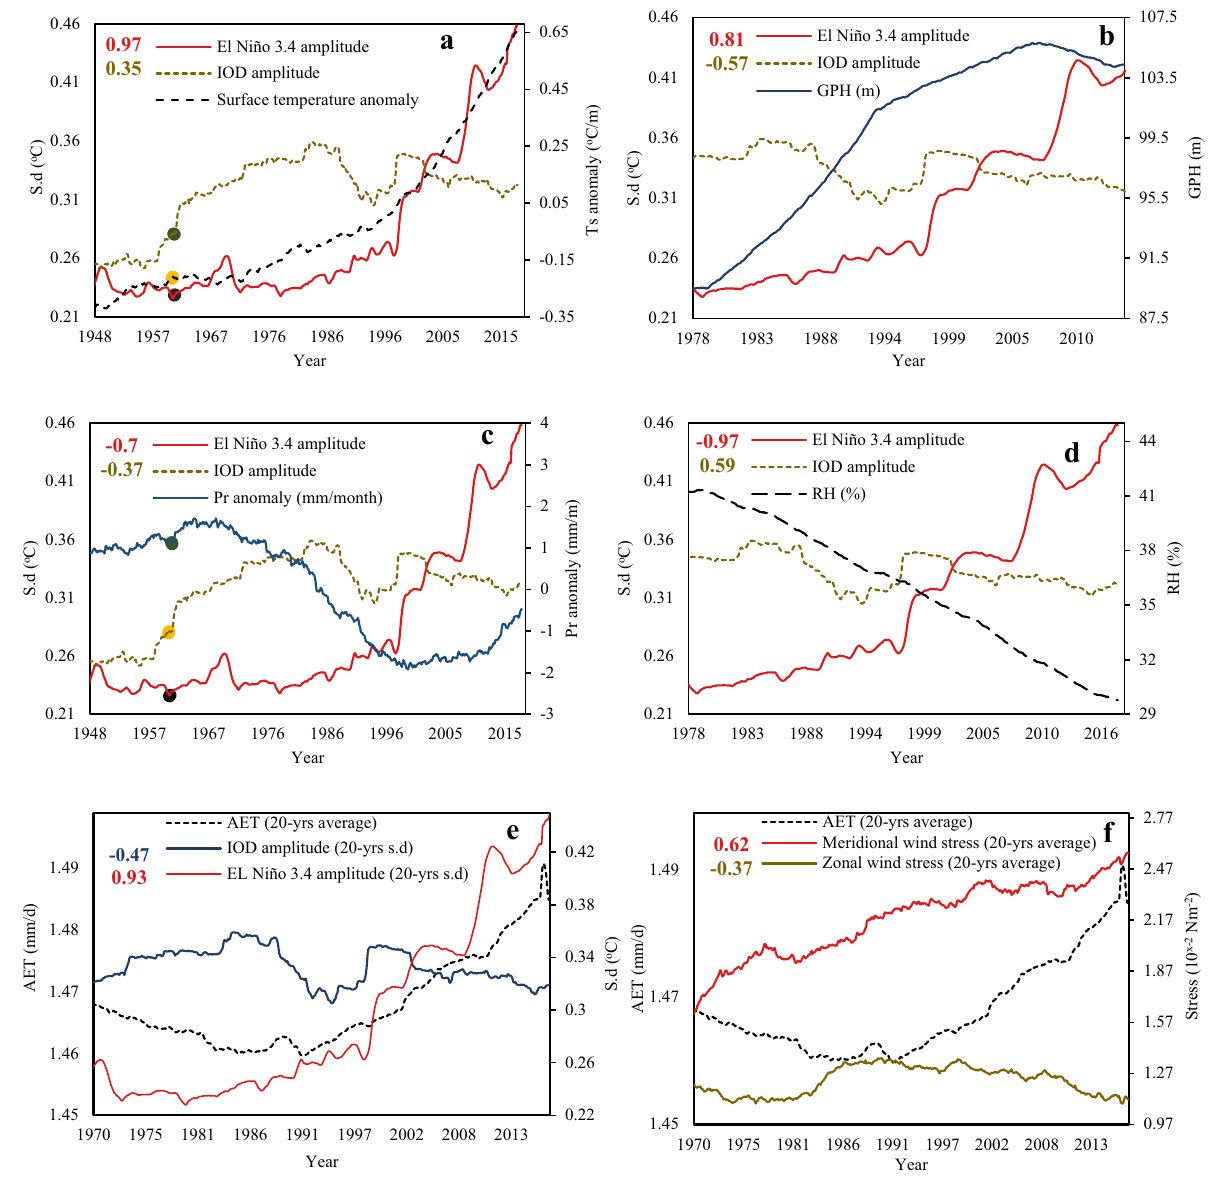
Figure 4. ENSO and IOD Teleconnections on NRB hydroclimate. IOD and El Niño 3.4 amplitudes correlations with NRB surface temperature ( a ), GPH ( b ), precipitation anomaly ( c ), relative humidity ( d ), AET ( e ), and AET correlation with meridional and zonal wind stress ( f ). Surface temperature anomaly, GPH, precipitation anomaly, and relative humidity are computed over 20-year running periods from 1920 to 2017, El Niño 3.4 and IOD amplitude are the SD of El Niño 3.4 and IOD indexes over 20-year windows from 1920 to 2017 using the ERSST data sets. The numbers in the top right are the cross-correlation coefficient between variables and IOD amplitude (brown colour) and El Niño 3.4 amplitude (red colour) at the 5% level. In ( a , c ) black and yellow points represent neutral ENSO conditions and strong positive IOD in 1961, green point is the response on surface temperature “increase” and decrease in precipitation anomalies “decrease” in the same